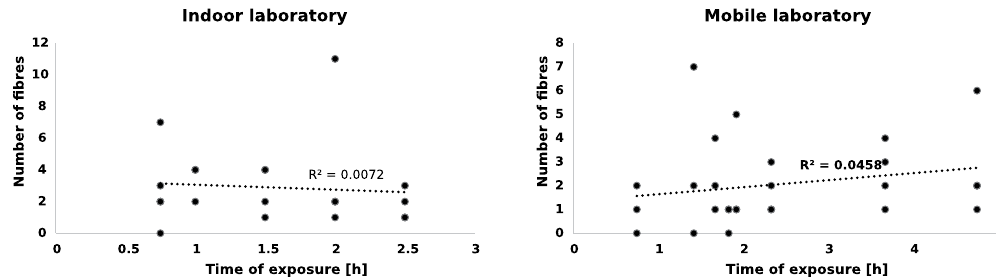
Figure 5. Linear regression analysis. Correlation between the number of fibres recovered on the filter papers and the time of exposure indoor (left) and in the mobile laboratory